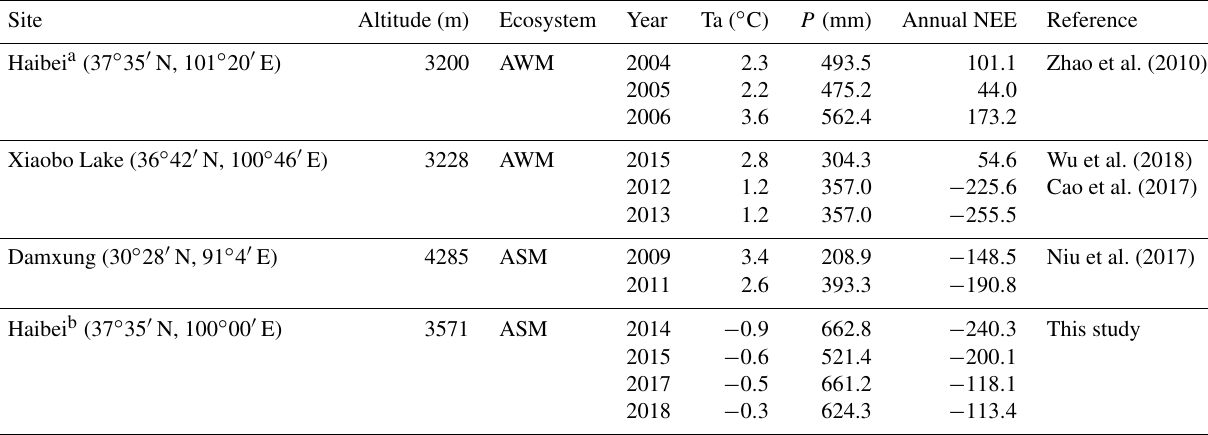
Table 2. Comparison of annual NEE (gCm − 2 yr − 1 ) at different sites in the QTP. Site Altitude (m)